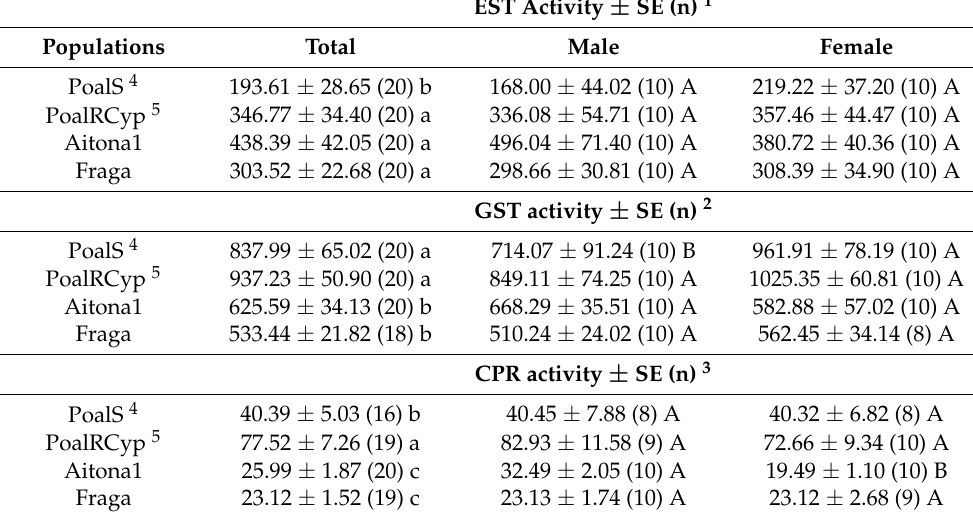
Table 3. Enzymatic activities of EST, GST and CPR in adults of C. pyri from two reared labora- tory strains and two field populations collected in the Ebro Valley area (Spain). N = number of insects